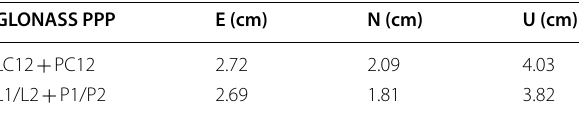
Table 3 Averaged RMS of E, N, and U components for different GLONASS PPP